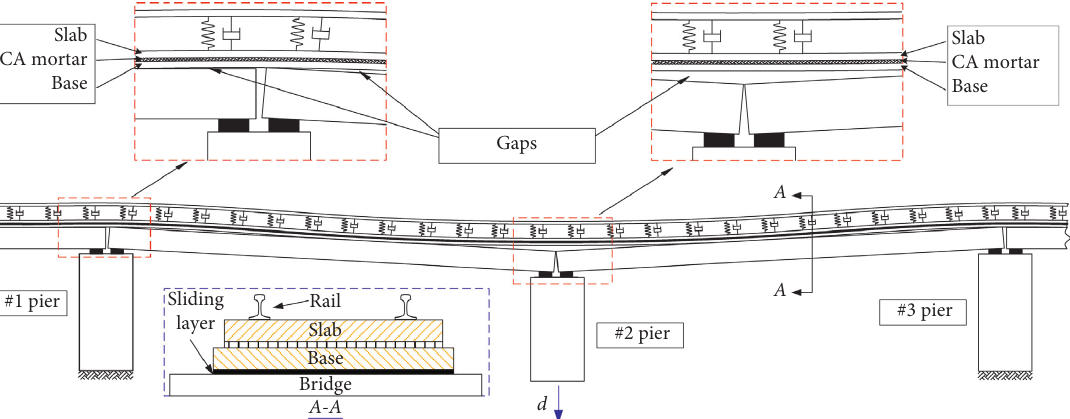
Figure 1: Deformation of LCT caused by pier settlement.